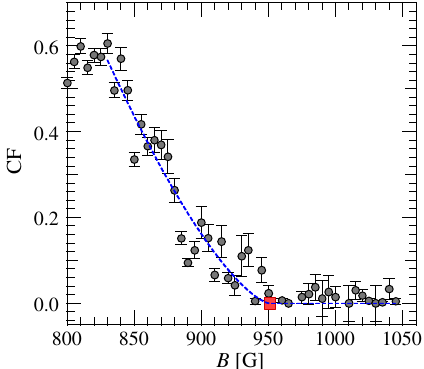
FIG. 11. Condensate fraction of paired fermions evaluated at various magnetic fields for the Feshbach resonance. The circles with error bars indicate experimental data. The dashed curve shows the fitting result. The red square corresponds to the point at which the condensate fraction